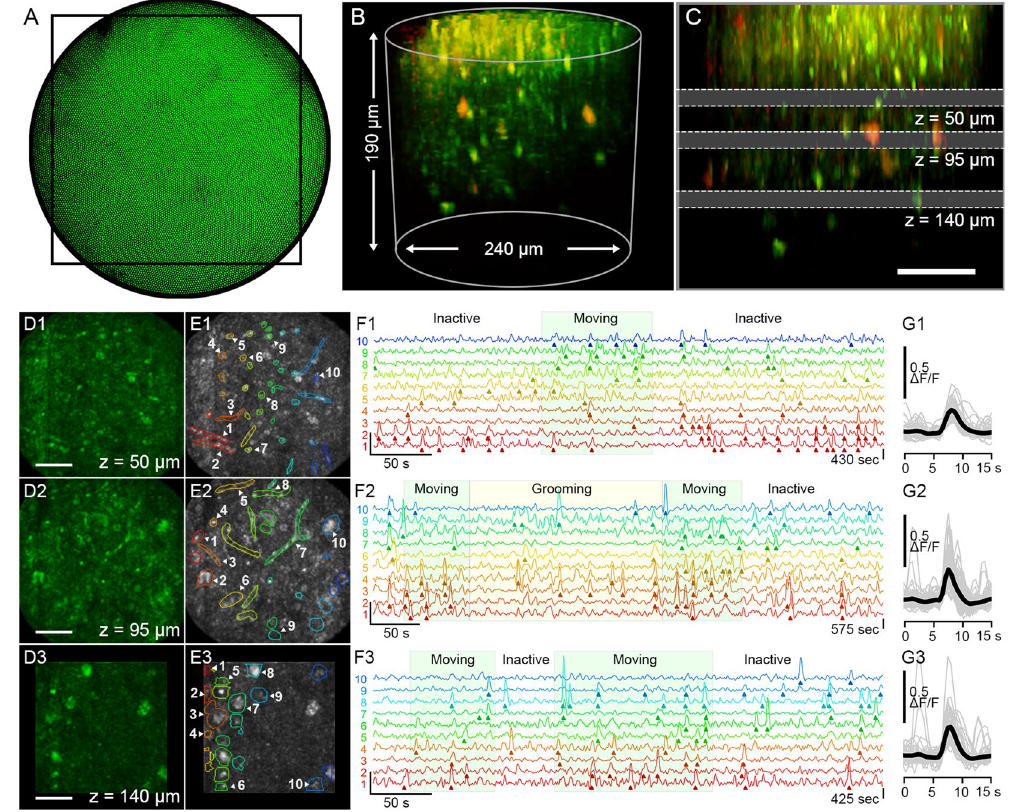
Figure 7. Two-photon Ca 2 + -imaging in an awake and freely-moving mouse using the 2P-FCM. ( A ) Widefield camera image of the epifluorescence taken through the FCM showing showing vasculature in the FOV. A black rectangle indicates the acquisition region for the following images. ( B ) 3D projection of a Z-stack acquired by sequentially imaging and focusing through the tissue using the EWTL. ( C ) Side projection of the same Z-stack indicating the three depths at which time series were acquired: at 50 µ m, 95 µ m, and 140 µ m depth, recorded at frame rates of 2.5, 1.3 and 2.0 Hz respectively. ( D ) Maximum intensity projections of image frames that coincide with Ca 2 + -transients, showing structural changes through the focal depths. Scale bar is 50 µ m. ( E ) Selected ROIs that contain fluorescence transients that exceed the 6 SD threshold. Time traces for ten representative ROIs are selected for each depth. ( F ) Detailed time-courses of the Δ F/F signal for the ten indicated regions. Regions of mouse behavioral activity from the camera recording are overlayed on the traces. ( G ) All identified transients, aligned by the peak Δ F/F signal, shown in gray with averaged intensity signal in